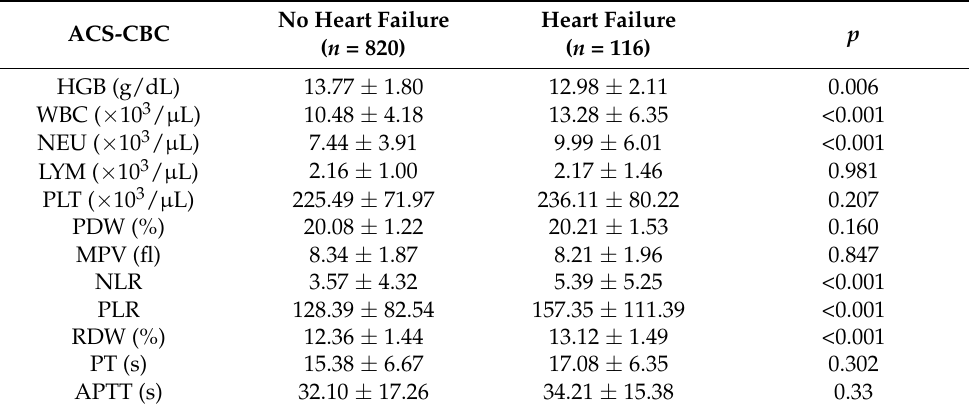
Table 11. Hematological and coagulation parameters between the groups with/without heart failure in ACS